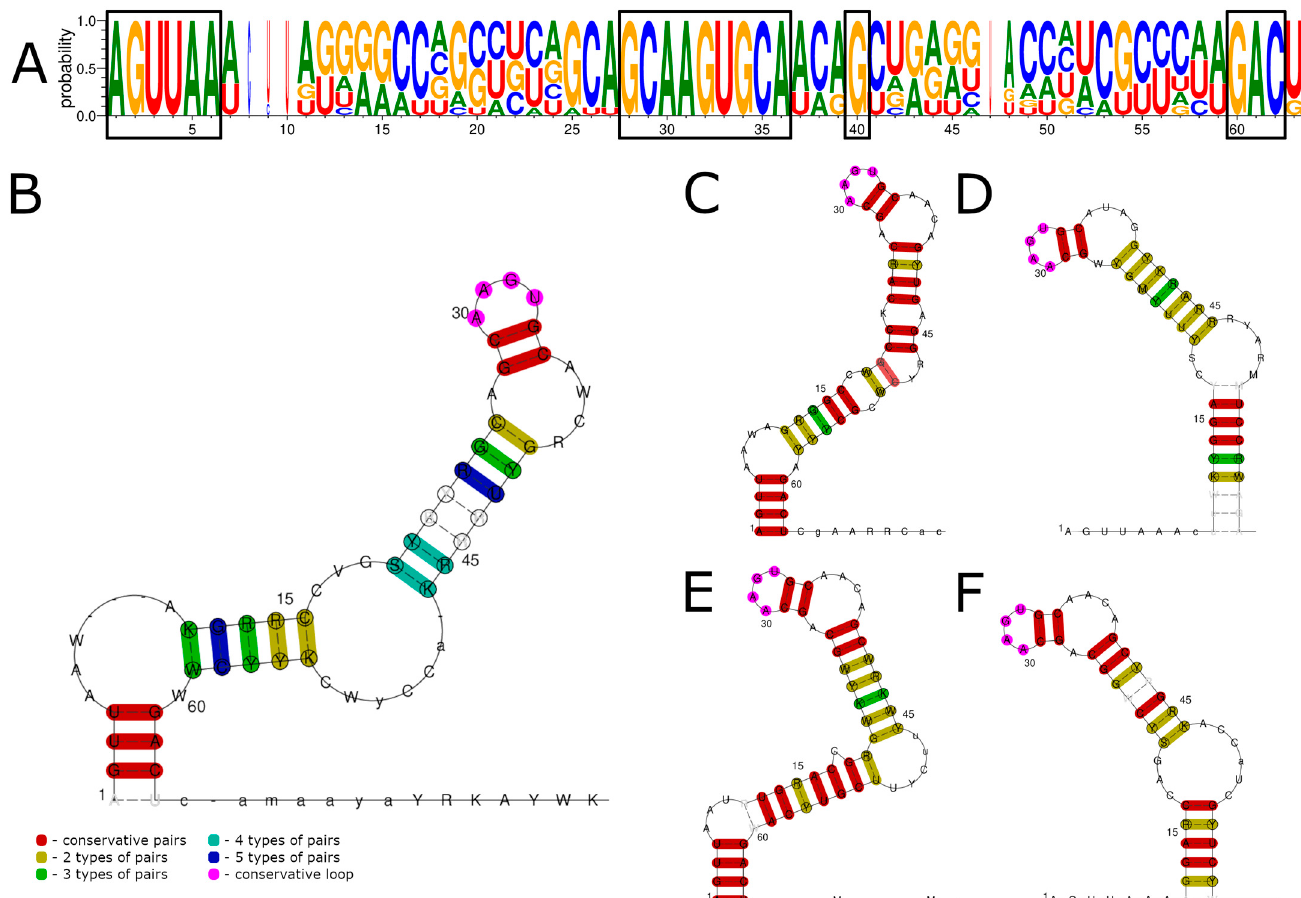
Figure 1. Consensus sequences and conserved RNA structures of 5 ′ UTRs of ALSV and YGTV studied in this work predicted using LocARNA. ( A ) Consensus sequences of all segments of the 5 ′ UTRs for ALSV and YGTV. ( B ) Conserved RNA structures of all segments of the ALSV and YGTV 5 ′ UTRs. Conserved RNA structures of segments one ( C ), two ( D ), three ( E ), and four ( F ). Conserved nucleotides in the consensus sequence are marked by black boxes. Nucleotide enumeration in fi gures ( B – F ) follows the enumeration in the alignment ( A ).